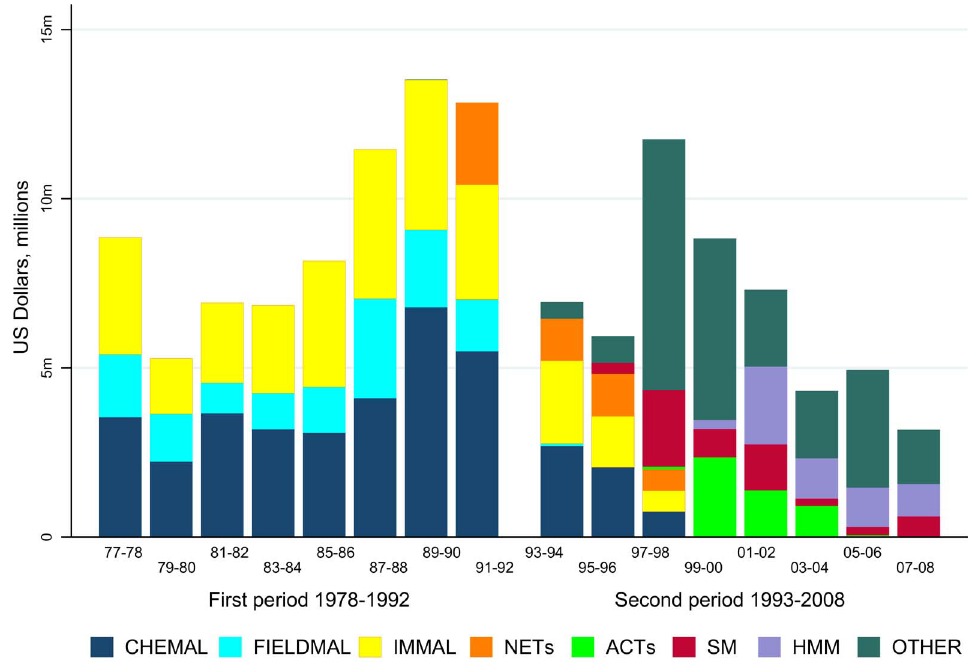
Fig. 3. Funding of malaria research by activity: committees 1977–1992 versus task forces 1993–2008. CHEMAL, Chemotherapy of malaria; FIELDMAL, Epidemiology of malaria; IMMAL, Immunology of malaria; NETs, bednets; ACTs, artemisinin combination therapy; SM, severe